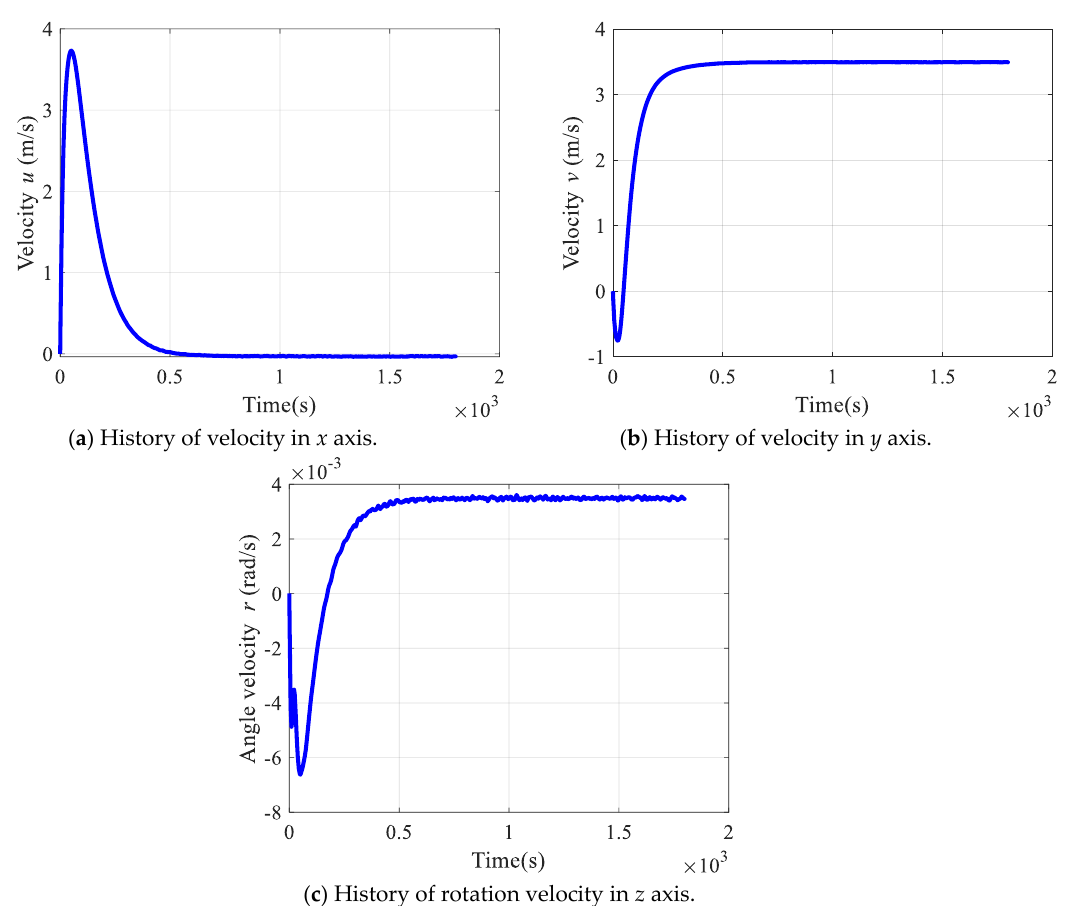
Figure 5. Histories of rotation velocities of controlled AUSV.